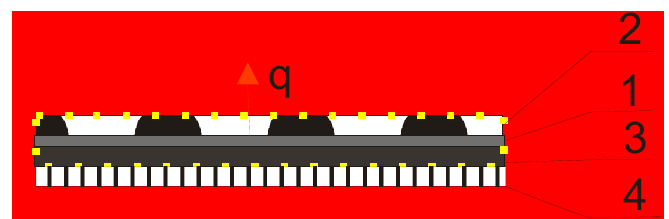
Figure 2. Diagram of the clothing package of the textronics system: 1—textronics heating insert; 2—outer insulating layer, made of non-woven viscose; 3—inner insulating layer made of woolen fabric; 4—a layer of a personal underwear; q—heat flux.